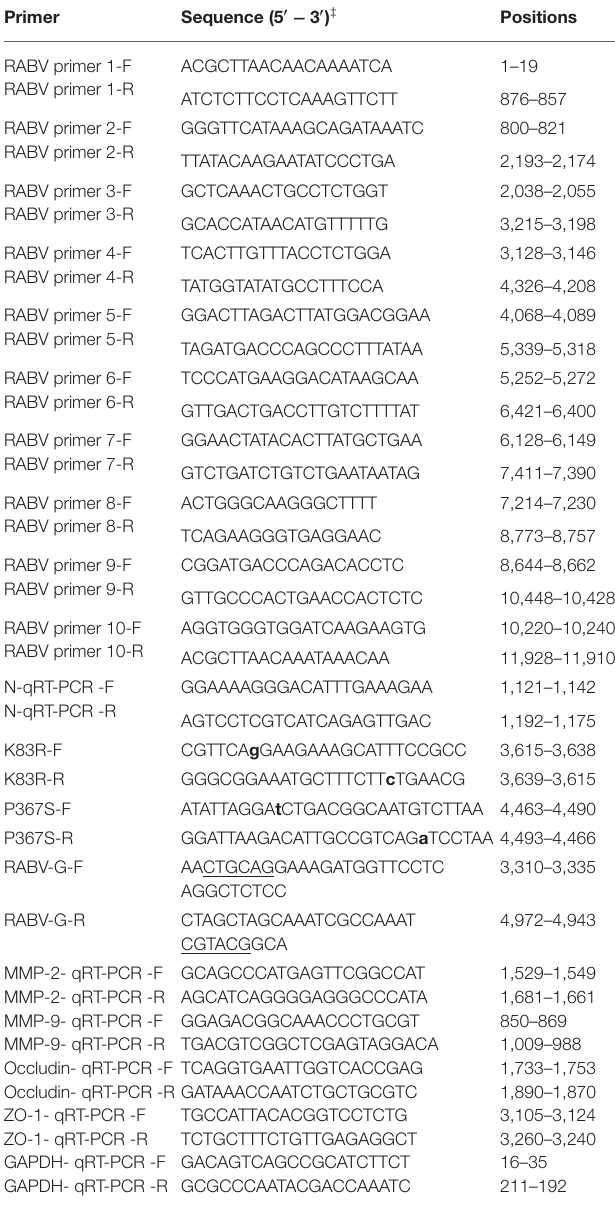
TABLE 1 | Primers used in the